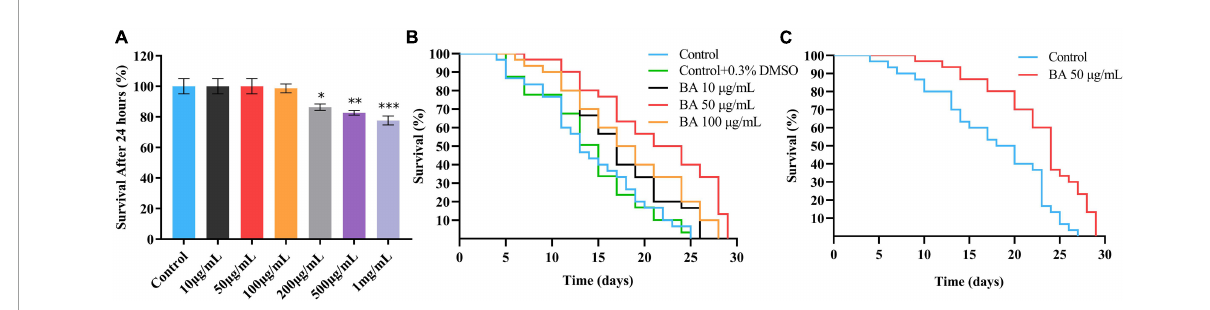
FIGURE1 Optimal dose of betulinic acid (BA) extends lifespan of Caenorhabditis elegans . (A) Survival rates of C. elegans after 24 h treatment with different doses of BA (0, 10, 50, 100, 200, 500, and 1,000 µ g/mL). (B) Lifespan analysis of C. elegans supplied with indicated BA (10, 50, and 100 µ g/mL) or vehicle (0.3% DMSO). (C) Lifespan analysis of C. elegans fed with inactivated Escherichia coli OP50 and BA (50 µ g/mL). For panel (A) , comparisons represent the One-way ANOVA followed by post-hoc Bonferroni’s test. Data were displayed as mean ± SEM. ∗ P < 0.05; ∗∗ P < 0.01; ∗∗∗ P < 0.001.